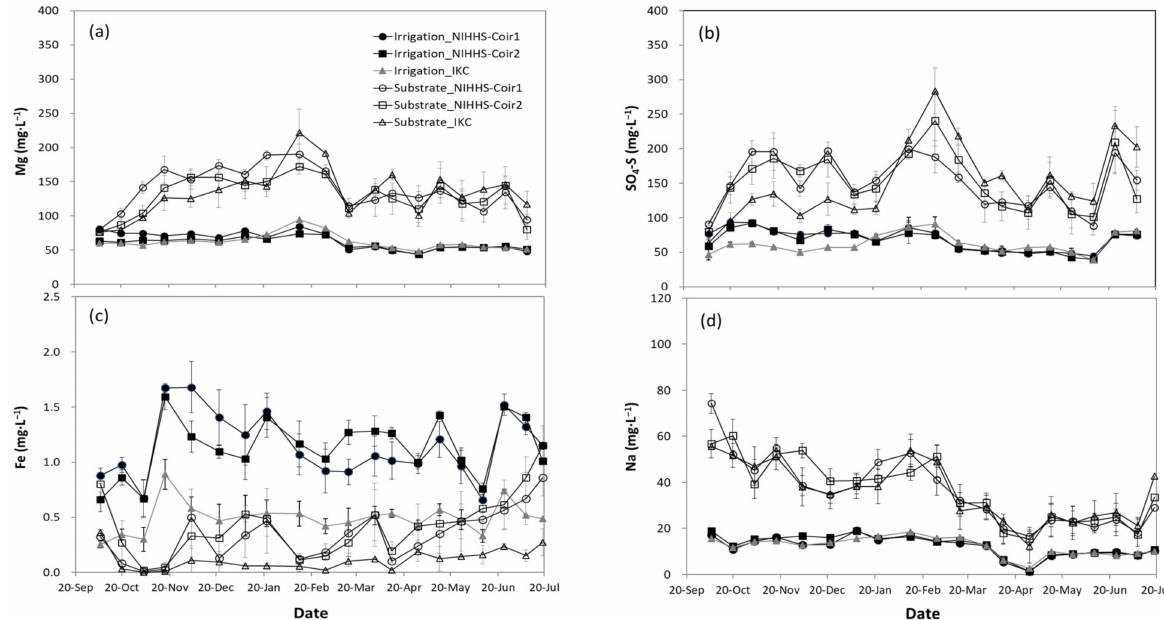
Figure 7. Changes in Mg ( a ), SO 4 -S ( b ), Fe ( c ), and Na ( d ) in the irrigation and RZ of each nutrient solution composition (NIHHS-Coir1, NIHHS-Coir2, and IKC) in the closed hydroponic system with a coir substrate. Vertical bars indicate standard errors of the means ( n =